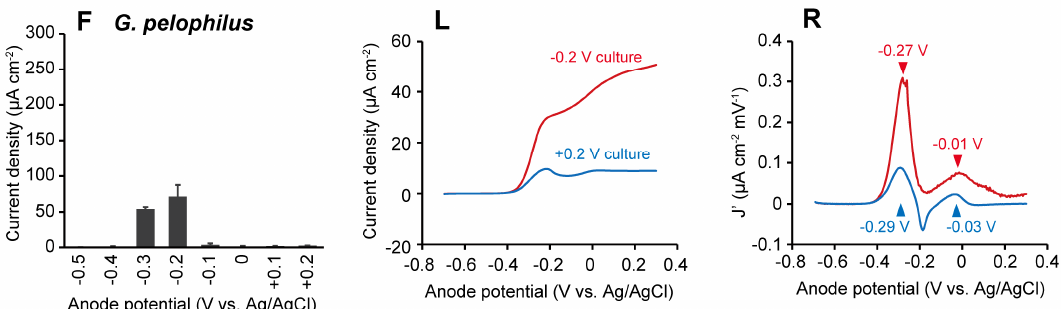
Figure 1. The effects of anode potentials on six Geobacter species. ( A – F ) The maximum current densities at each anode potentials. Data are presented as the means of three independent cultures and error bars represent standard deviations. ( G – L ) The linear sweep voltammetry (LSV) patterns (scan rate of 5 mV · s − 1 ) of six Geobacter species cultivated at − 0.2 (red) and +0.2 (blue) V vs. Ag/AgCl. In ( I , J ) the current densities of +0.2 V cultures are enlarged ( × 5). ( M – R ) The first derivative of the LSV data shown in ( G – L ). Arrowheads indicate peak potentials.